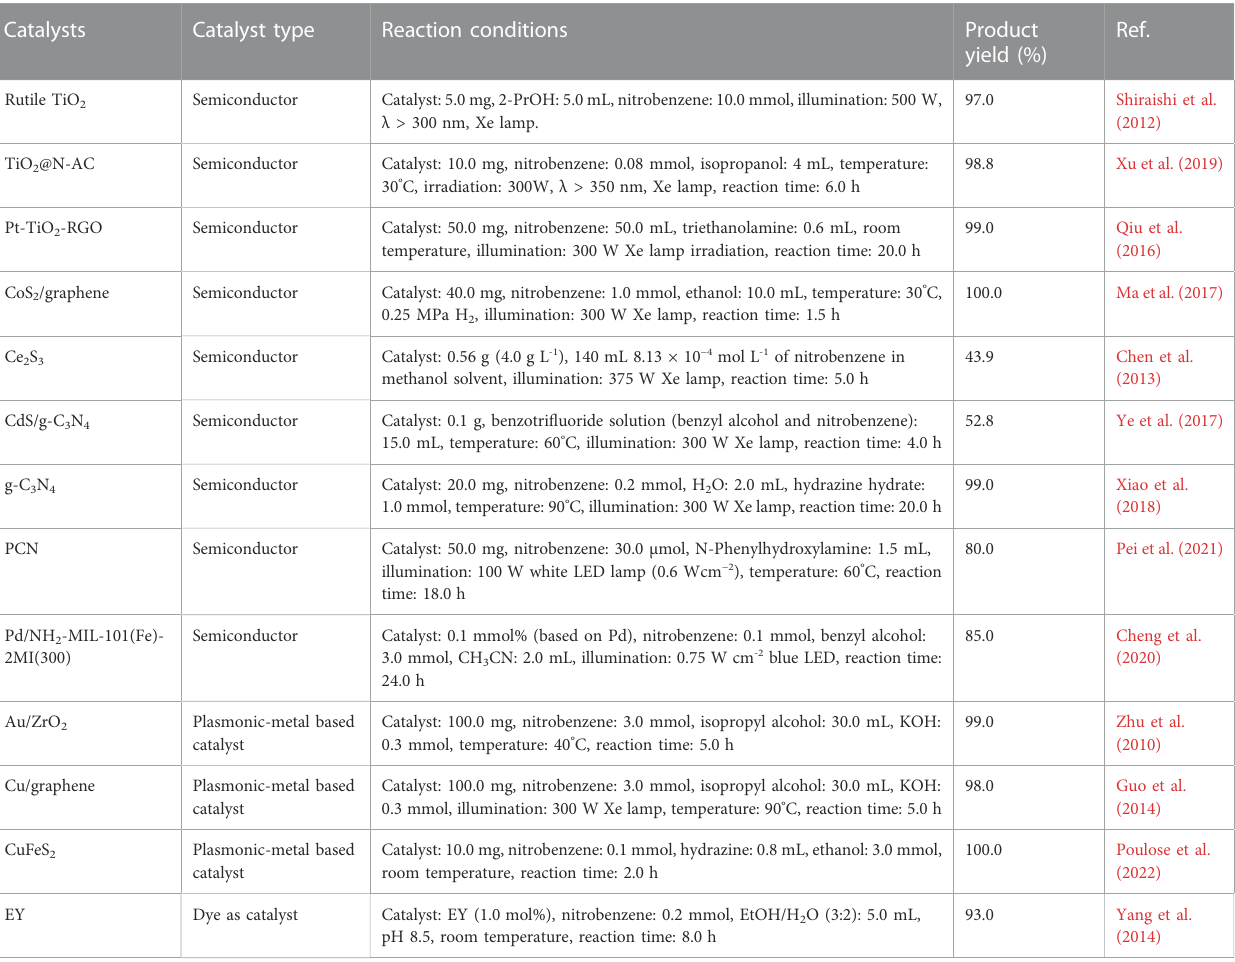
TABLE 1 The performance of some typical catalysts in SHN reaction. Catalysts Catalyst